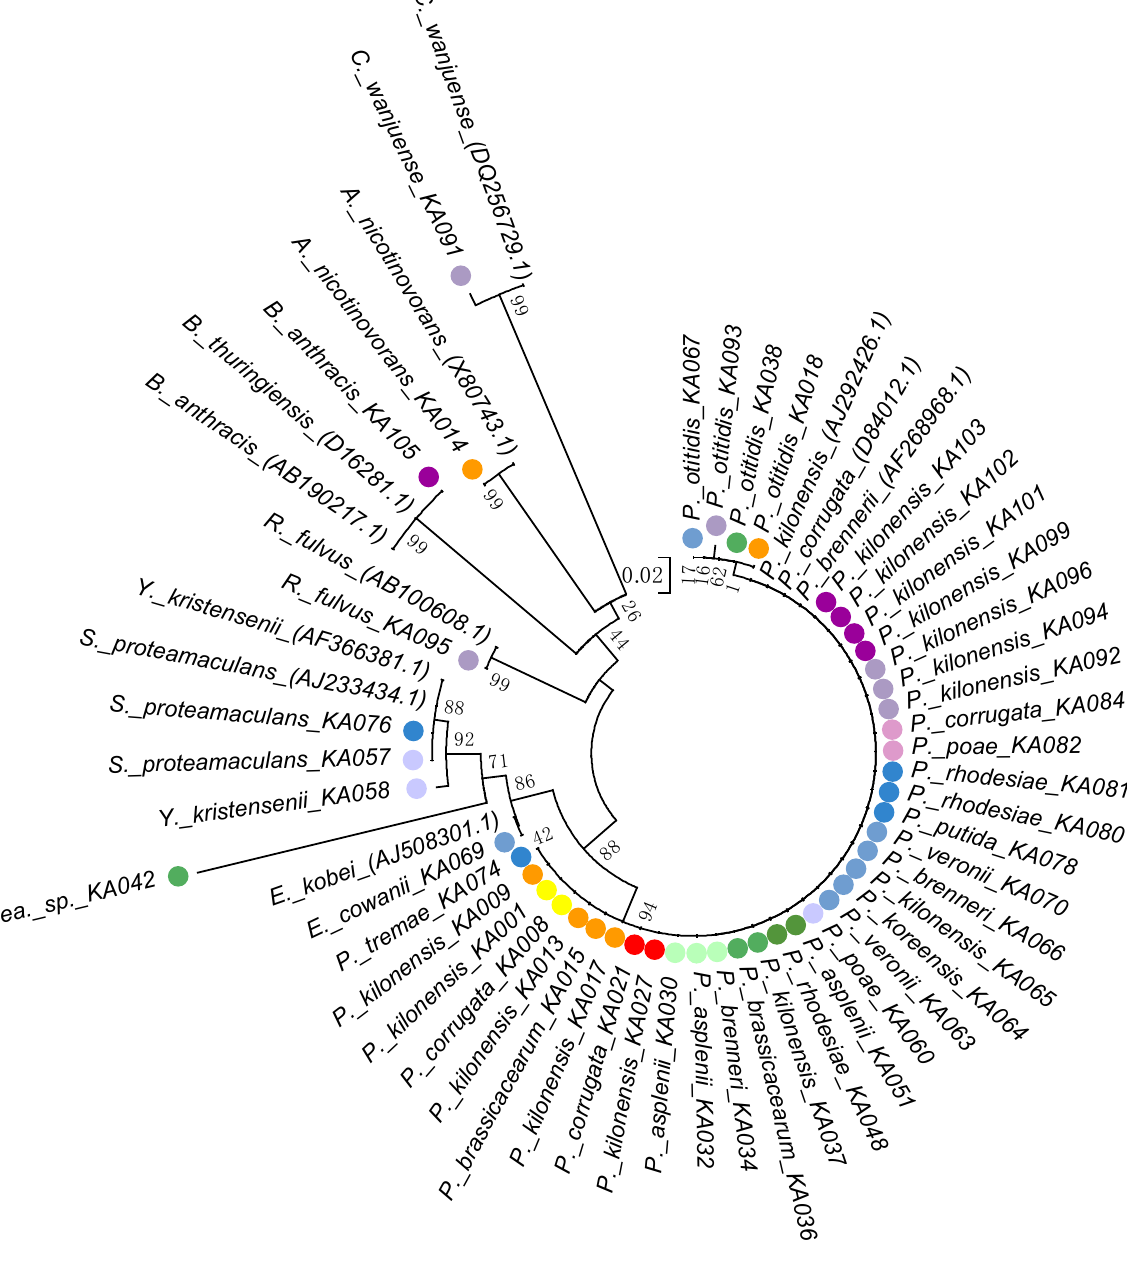
Figure 4. Phylogenetic composition of the antagonistic community selected by bait plants. The tree is comprised of 47 partial 16S rRNA gene sequences. Neighbor-joining phylogenetic tree (maximum composite likelihood method) was constructed with both one representative sequence per major species and the nearest reference sequences (accession numbers in brackets). The reliability of the tree topology was evaluated using bootstrap analysis with 10,000 re-samplings. Color code: rhizosphere samples from maize, yellow/orange/red; oilseed rape, green shades; sorghum, blue shades; sugar beet, purple shades. Sequences of MF2-1-4 (KA3) and ZM1-1-3 (KA90) were excluded from MEGA5 analysis due to their short sequence